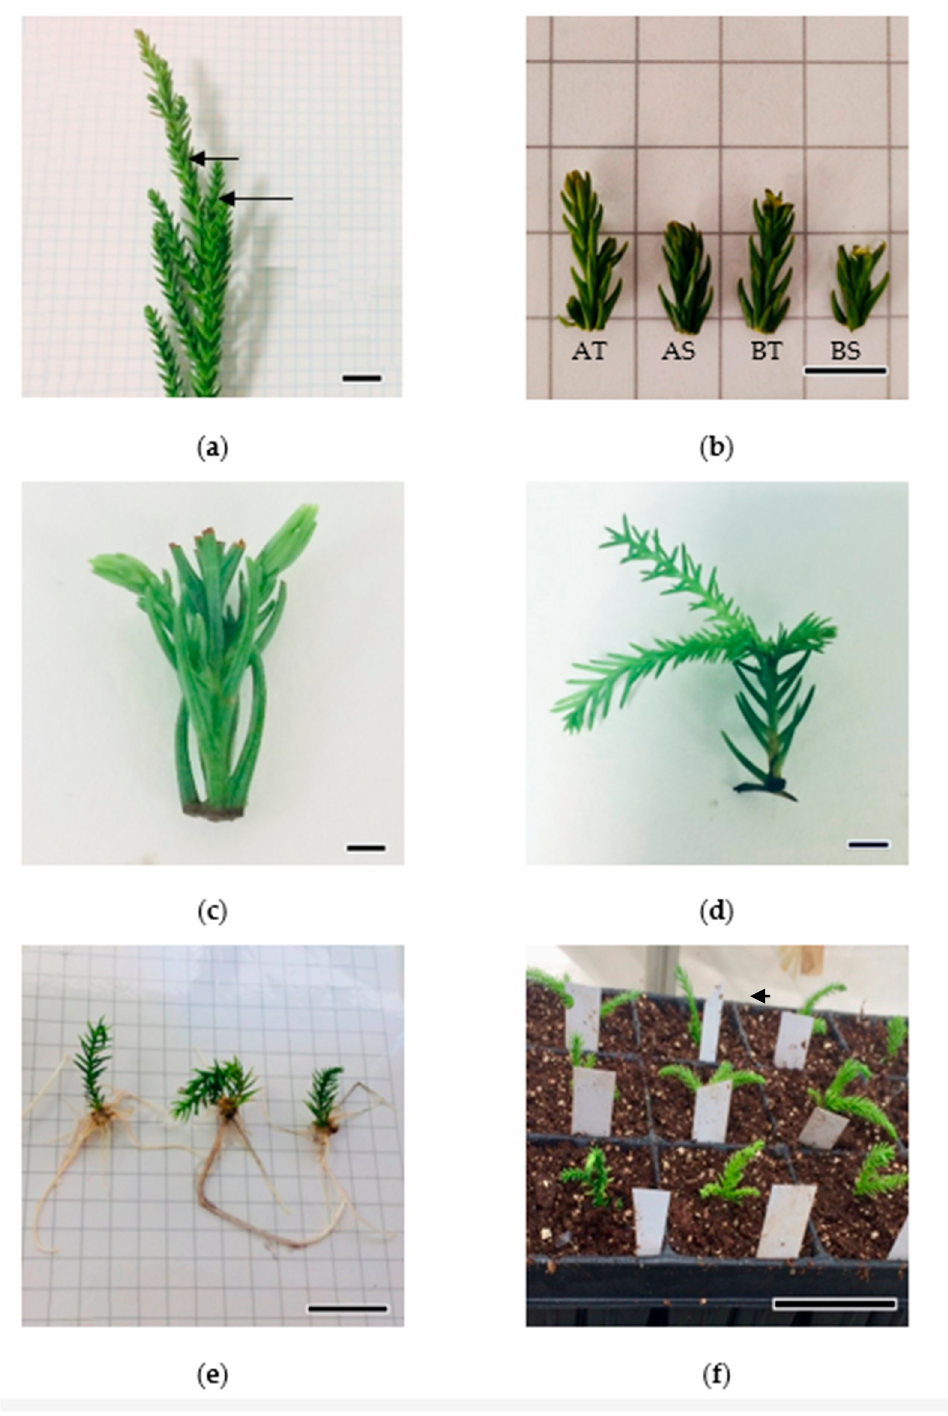
Figure 1. Plant material at different stages of Cryptomeria japonica micropropagation process: ( a ) actively growing twigs used as starting explants; arrows show the explants used for in vitro culture establishment, bar = 30 mm; ( b ) explant type; apical explants > 1.5 cm (AT), apical explants < 1.0 cm (AS), basal explants > 1.5 cm (BT) and basal explants < 1.0 cm (BS), bar = 10 mm; ( c ) basal explants of 2.0 cm length after 4 weeks cultured in QL medium [15] supplemented with 8.8 μ M BA, bar = 30 mm; ( d ) elongated shoots after 6 weeks in hormone-free QL medium supplemented with 2 gL − 1 activated charcoal, bar = 30 mm; ( e ) rooted shoots after six weeks in hormone-free QL medium supplemented with 2 gL − 1 activated charcoal and under red LEDs, bar = 30 mm; ( f ) plantlets after four weeks in ex vitro conditions in the greenhouse, bar = 30 mm.